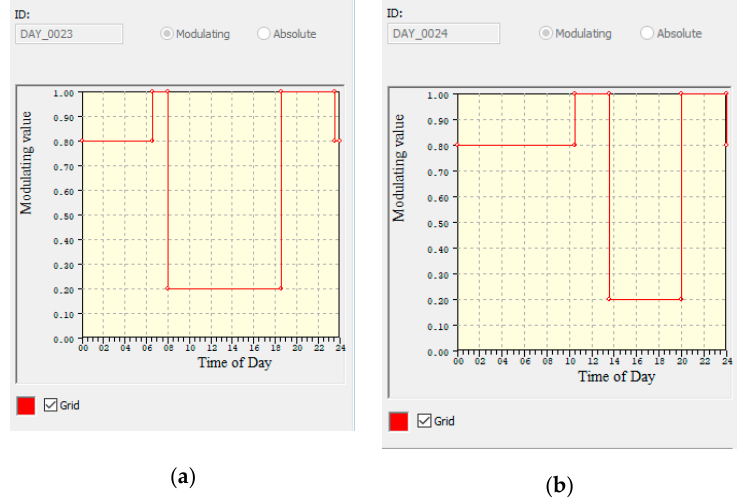
Figure 4. The occupants schedule as inputted in IES-ve for; ( a ) Weekdays; ( b ) Weekends. From the information collected from the construction site, each apartment has 11 100W incandescent light bulbs, each emitting 15 W/m 2 , with a radiant fraction of 0.45, and 45% of the emitted gains are assumed to be radiated as long waves absorbed by the internal surfaces. The lighting schedule is assumed to be correspondent to the occupants’ schedule. The other appliances are assumed to be emitting 5 W/m 2 as sensible load and 0.75 W/m 2 as latent load, according to [17], and have the same lighting schedule. The infiltration rate is assumed to be 0.8 air change hour (ACH). For the HVAC system, the apartments have a set point of 25 °C for cooling and 18.3 °C, according to the Egyptian code of energy efficiency in residential buildings. The air-conditioning (AC) system is modelled as an ideal split system, considering that the energy efficiency ratio (EER) varies with the external temperatures, as shown in Figure 5 [19].